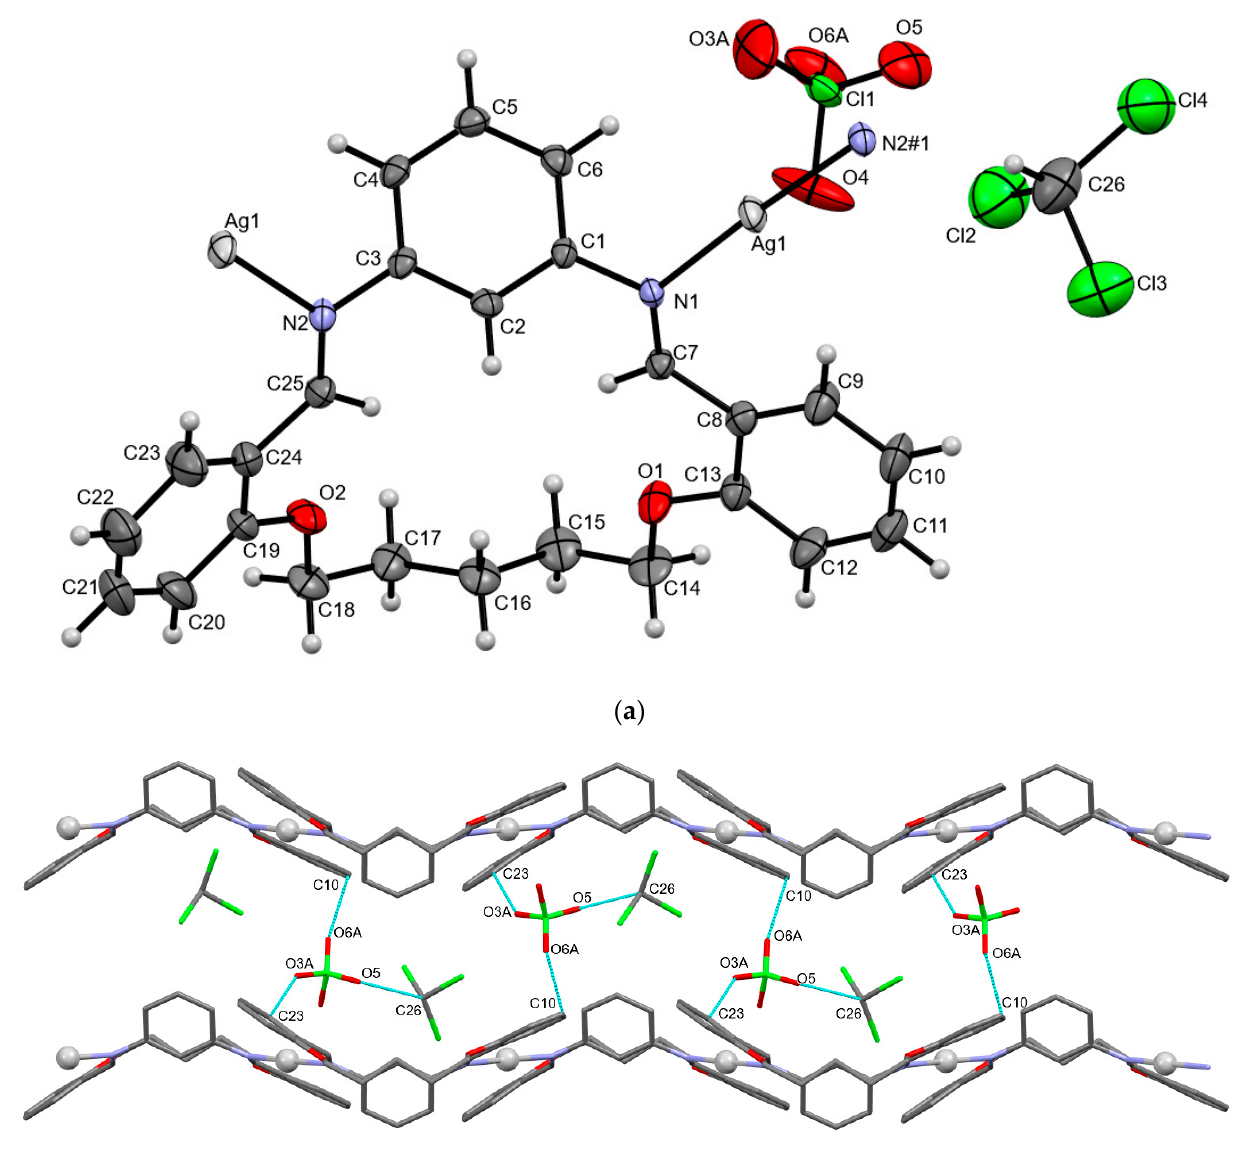
Figure 1. ( a ) ORTEP plot of AgLClO 4 with displacement ellipsoids of non-hydrogen atoms drawn at the 50% probability level. Symmetry operation: #1 1 − x , − 1/2 + y , 1/2 − z . ( b ) Representation of C–H ··· O intermolecular interactions (light blue lines) in AgLClO 4 (hydrogen atoms are omitted for clarity and silver ions are represented as spheres). The view is down the a axis.